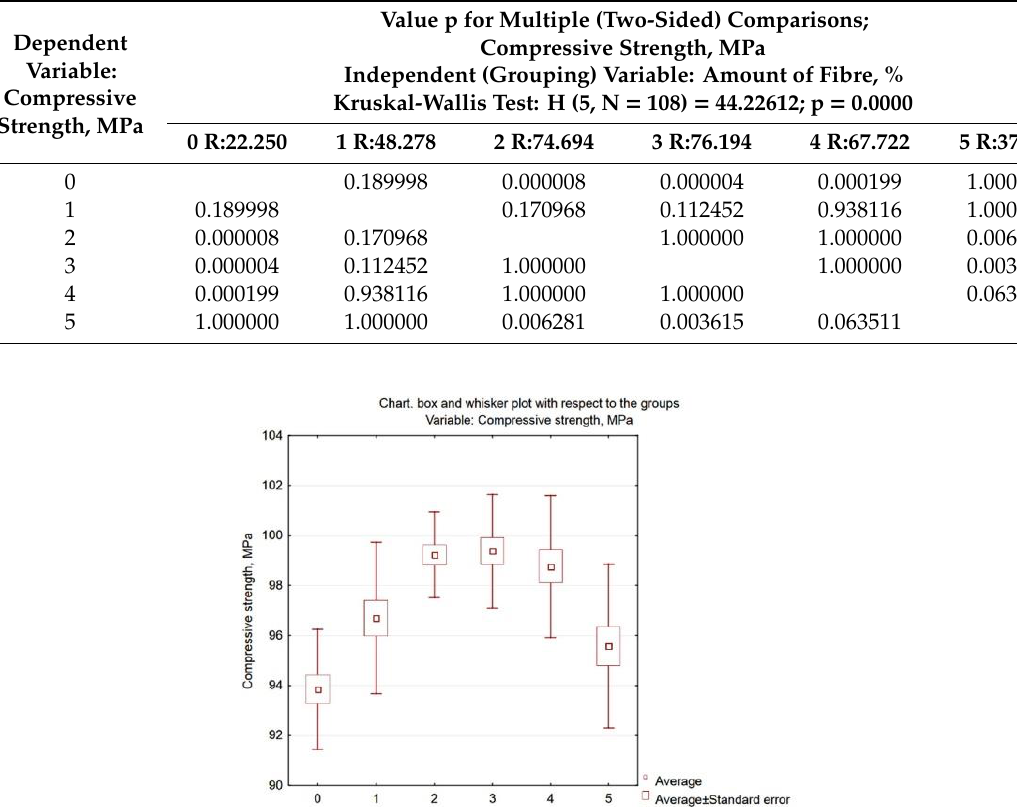
Table 13. Values p for two-sided comparisons.